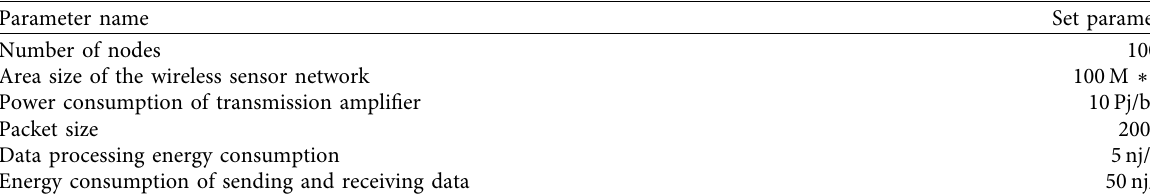
Table 1: Setting of simulation parameters.